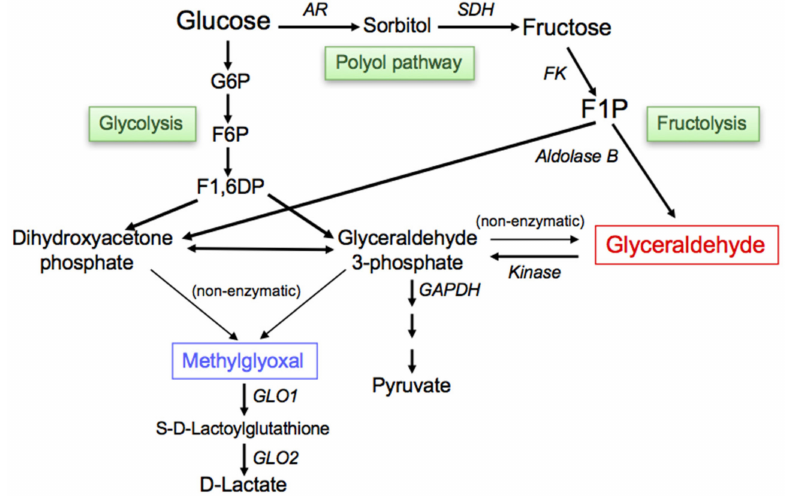
Figure 2. Routes for the in vivo production of glyceraldehyde (GA)/methylglyoxal (MGO). The glycolytic intermediate glyceraldehyde 3-phosphate (GA3P) is generally catabolized (glycolysis) by the enzyme GA3P dehydrogenase (GAPDH). However, decreases in the enzymatic activity of GAPDH result in the intracellular accumulation of GA3P. As a consequence, GA3P is metabolized via an alternative pathway, which increases the concentration of GA. Fructokinase phosphorylates fructose to fructose 1-phosphate (F1P), which is then converted into dihydroxyacetone phosphate (DHAP) and GA by aldolase B (fructolysis). MGO is mainly produced as a byproduct of non- enzymatic reactions with GA3P or DHAP during glycolysis. The most effective MGO metabolic pathway is the glyoxalase system, which converts MGO to D-lactate. G6P: glucose 6-phosphate; F6P: fructose 6-phosphate; F1,6DP: fructose 1,6-diphosphate; AR: aldose reductase; SDH: